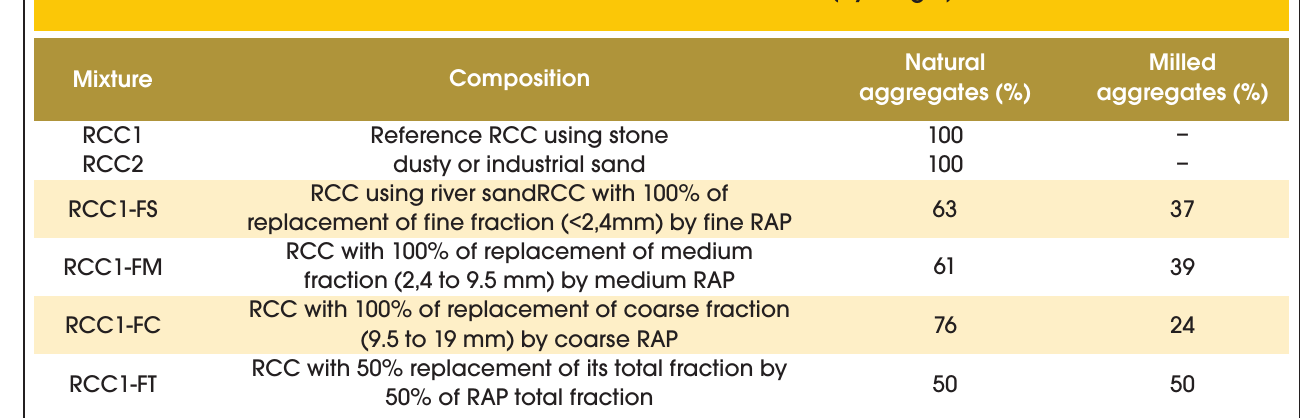
Table 1 – Size distribution of RCC mixtures (by